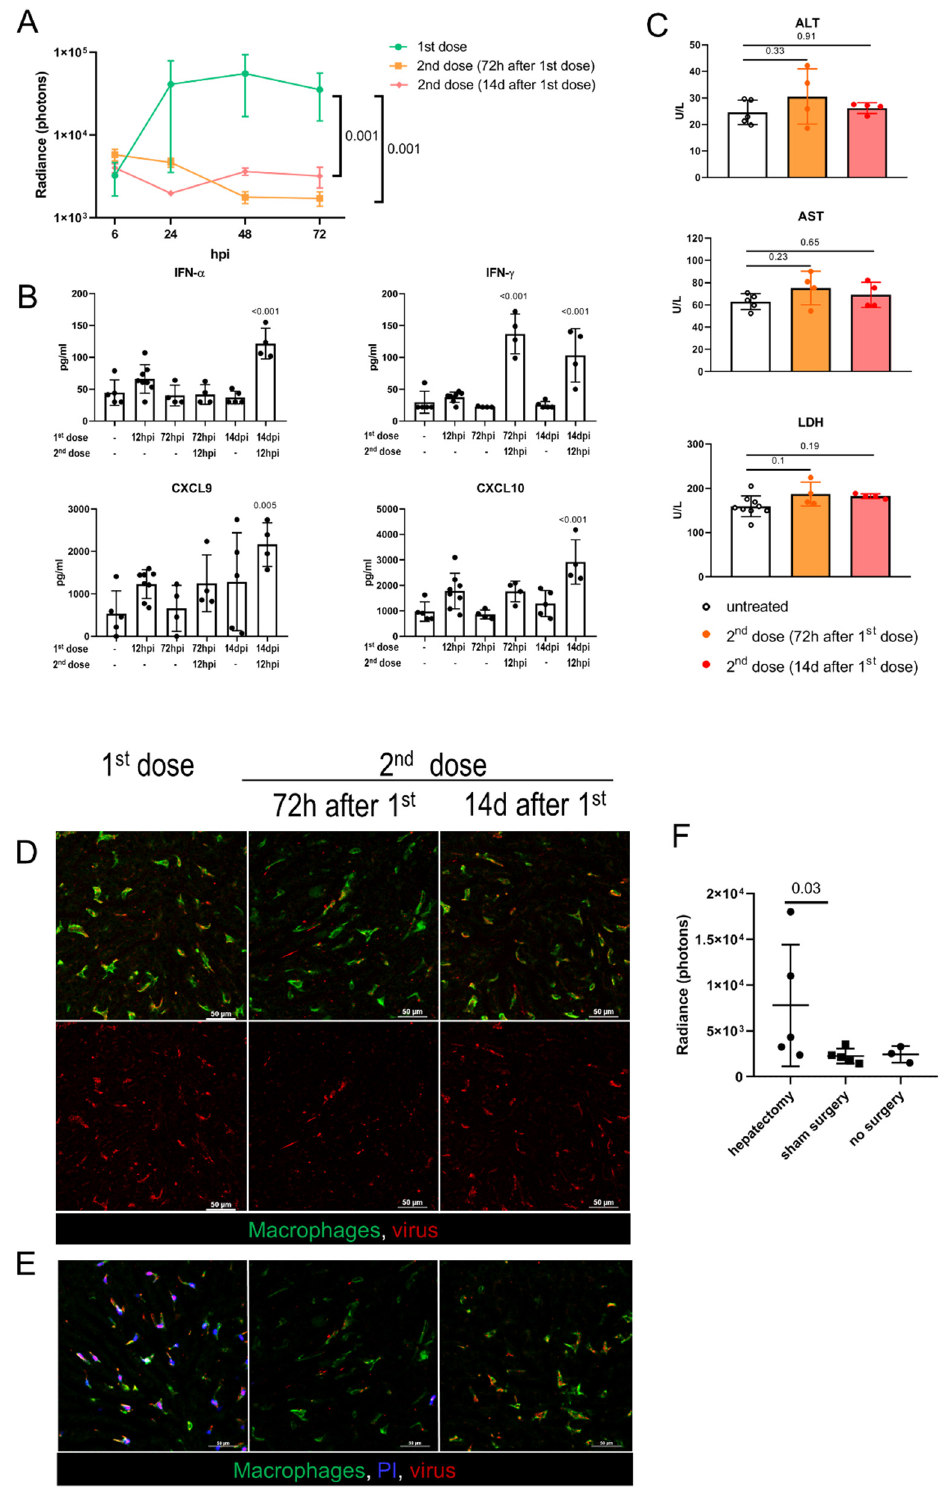
Figure 4. Adenovirus infection and toxicity in preimmunized hosts and in regenerating liver. ( A ). Ad5-RGD-Fluc (7 × 10 8 IFU) liver transduction rates measured by bioluminescence in naïve mice (first dose, n = 5) and mice pretreated with 7 × 10 8 IFU Ad5-RGD-EGFP 72 h (second dose (72h after 1st dose); n = 5) or 14 days (second dose (14d after first dose); n = 3) before rechallenge (mean ± SD; p -values are shown on graph; two-way ANOVA followed by Dunnett’s multiple comparisons test); ( B ) . Plasma levels of selected cytokines in different treatment schedules (mean ± SD; p -values are shown on graph; one-way ANOVA followed by Dunnett’s multiple comparisons test); ( C ). Plasma levels of ALT, AST, and LDH measured at 12 hpi of the repeated Ad5-RGD dose (7 × 10 8 IFU) re-